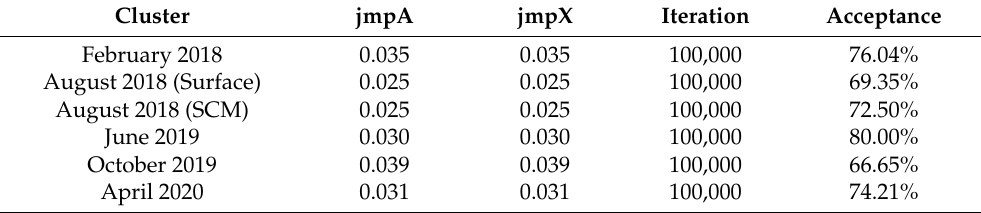
Table 3. The outputlengths parameter was set to 100, and other setting values used the default values of the BCE1 function in the BCE package. Table 3. Final settings used for BCE analysis and the resulting acceptance rates.